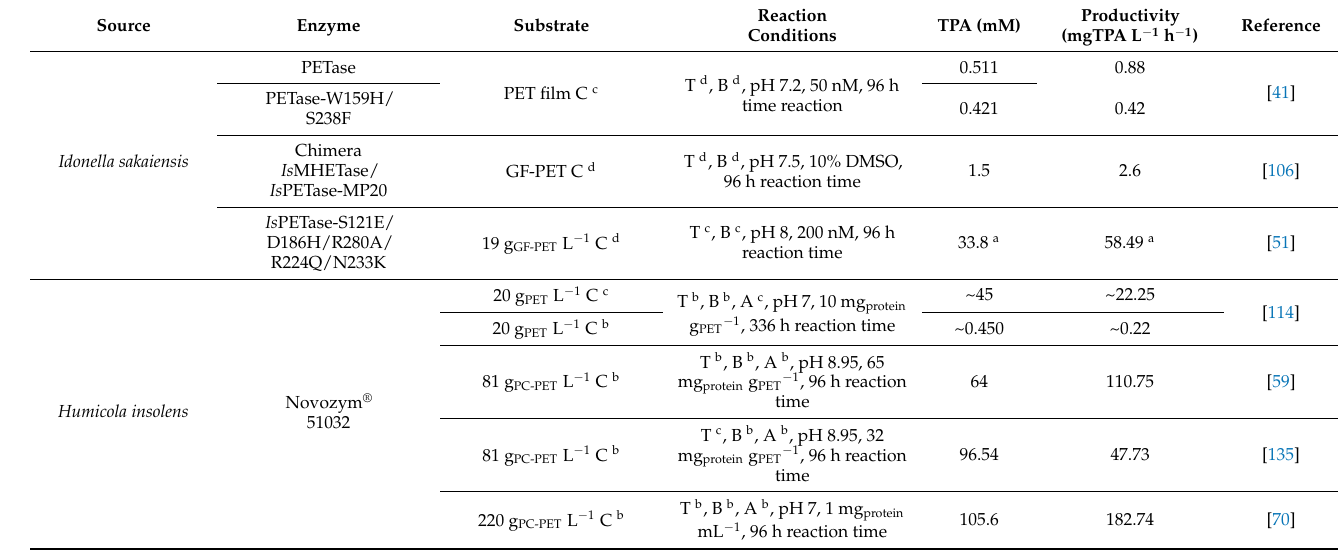
Table 1. Depolymerization of PET samples by PET